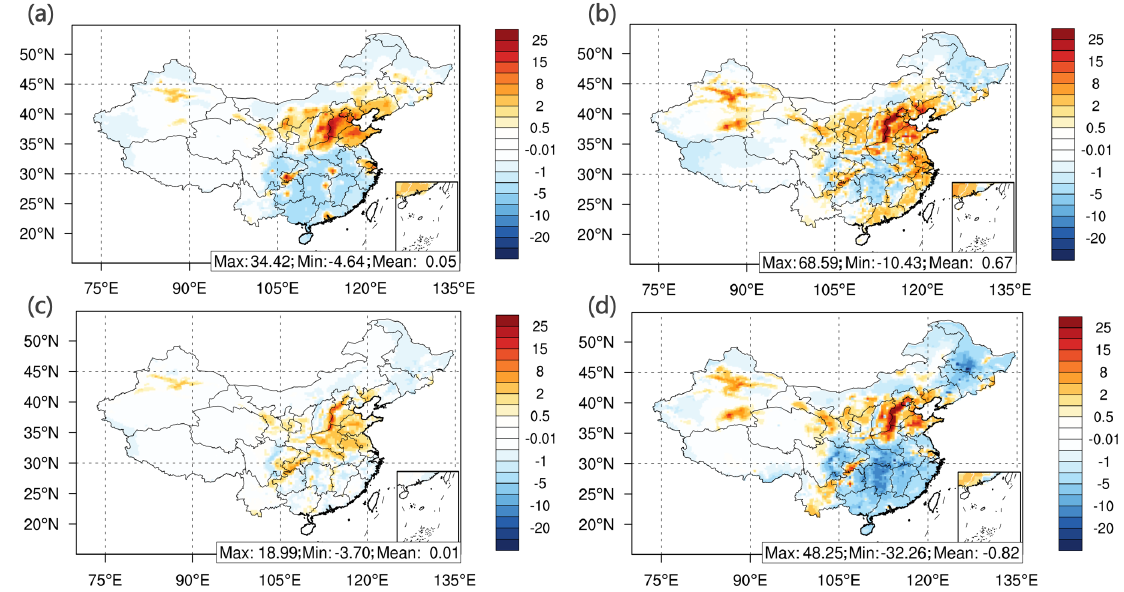
Figure 6. The difference in the spatial pattern of PM 2 . 5 compositions between InMAP-China and WRF-CMAQ. Panels (a) , (b) , (c) and (d) display sulfate, nitrate, ammonium and primary PM 2 . 5 , respectively.